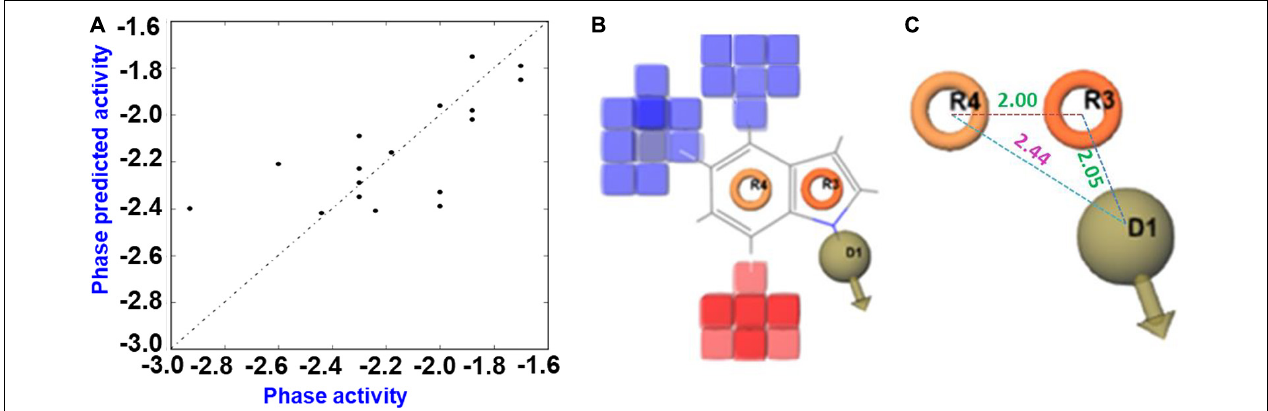
FIGURE 6 | QSAR prediction of halogenated indoles against V. parahaemolyticus . Fitness diagram between the observed and phase-predicted activity halogenated indoles (A) , 3D-QSAR representation of various substituents (blue cubes with positive potential and red cubes with negative potential) (B) , and essential pharmacophore halogenated indoles against V. parahaemolyticus (C)